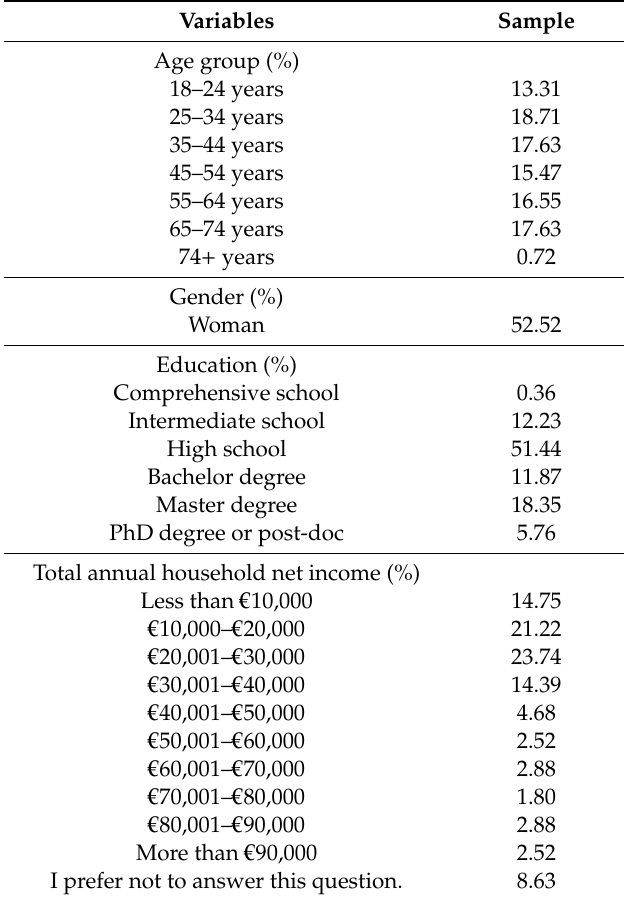
Table 2. Socio-demographic characteristics of respondents ( n =